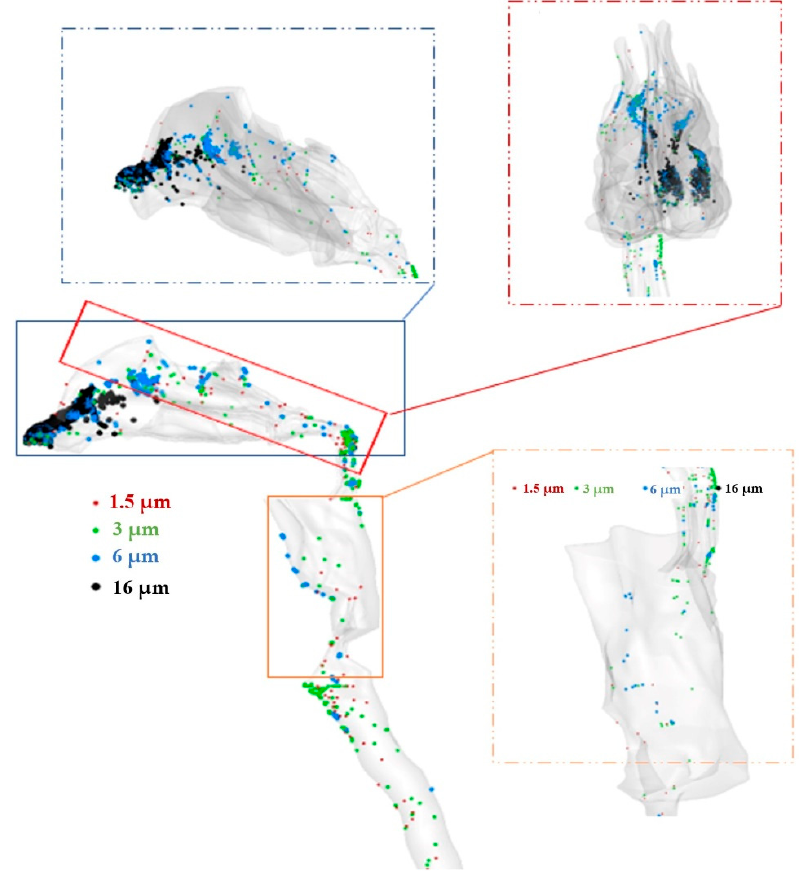
Figure 11. Deposition pattern of aerosols of different sizes and an inlet airflow rate of Q = 10 L/min.